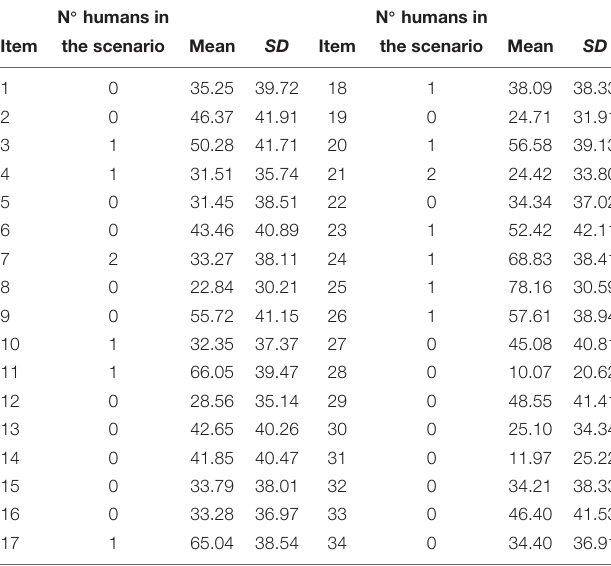
FIGURE 2 | ISS distribution (individual averages, N = 106).